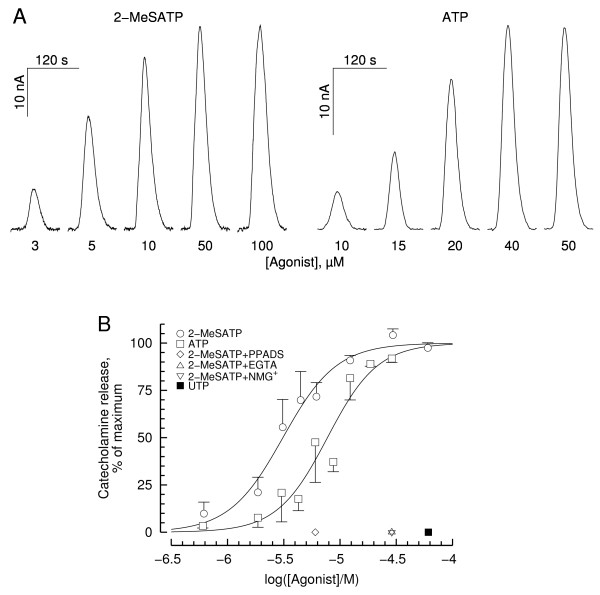
Effects of 2-MeSATP and ATP on catecholamine release. A. Amperometric currents recorded from chromaffin cell batches in response to brief pulses of increasing 2-MeSATP and ATP concentrations. Cells were allowed to rest for ~10 min between successive applications. Nominal agonist concentrations (in μM) are indicated beneath each trace. Nominal concentrations of test agents are used throughout this legend. Actual concentrations at the cell bed differ from nominal concentrations by a factor of 1.64 (see Methods). Concentrations along the X axis in Fig. 3B are actual concentrations at the cell bed; B. Dose-response curves of catecholamine release evoked by 2-MeSATP and ATP (circles and squares, respectively). Data from the experiment depicted in A and two similar experiments. Also depicted are data for UTP (100 μM; filled square) as well as for 2-MeSATP stimulations in presence of 50 μM PPADS (diamond), in the virtual absence of extracellular Ca2+ (EGTA-containing solution, inverted triangle) and in absence of extracellular Na+ (Na+ replacement for NMG+, triangle) (n = 3 experiments for each condition).